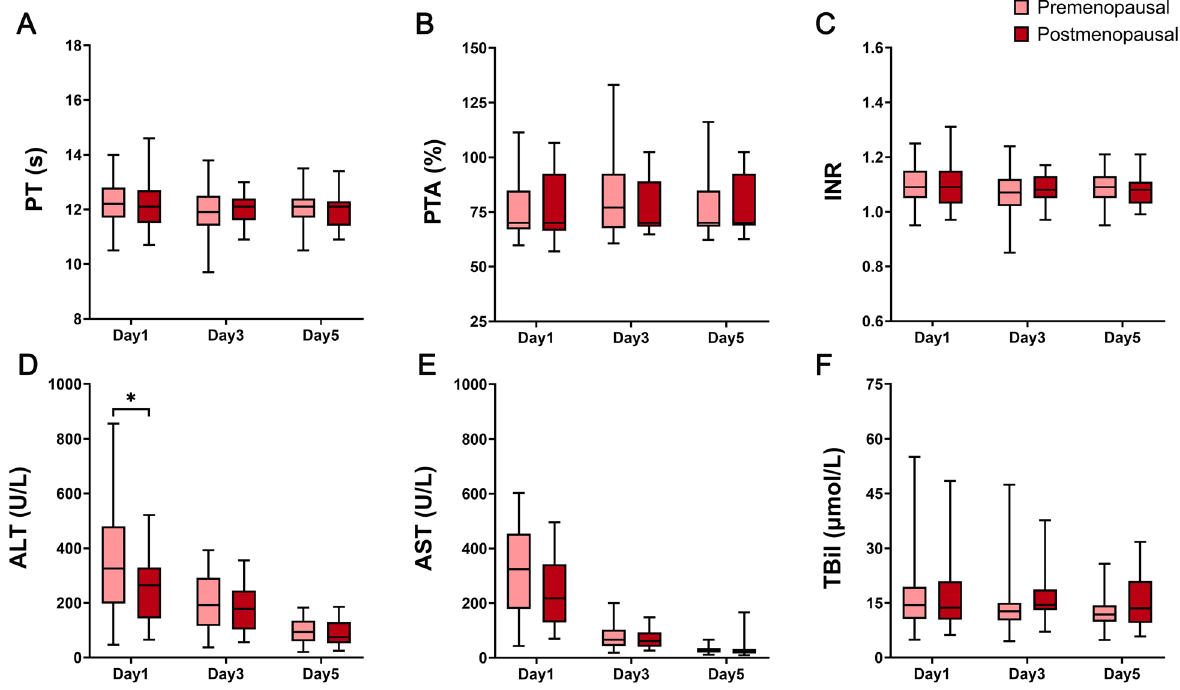
Figure 3. Comparison of coagulation function and liver function between premenopausal group and postmenopausal group. ( A ) PT, ( B ) PTA, ( C ) INR, ( D ) ALT, ( E ) AST, ( F ) TBil (* P < 0.05, ** P < 0.01, *** P < 0.001).